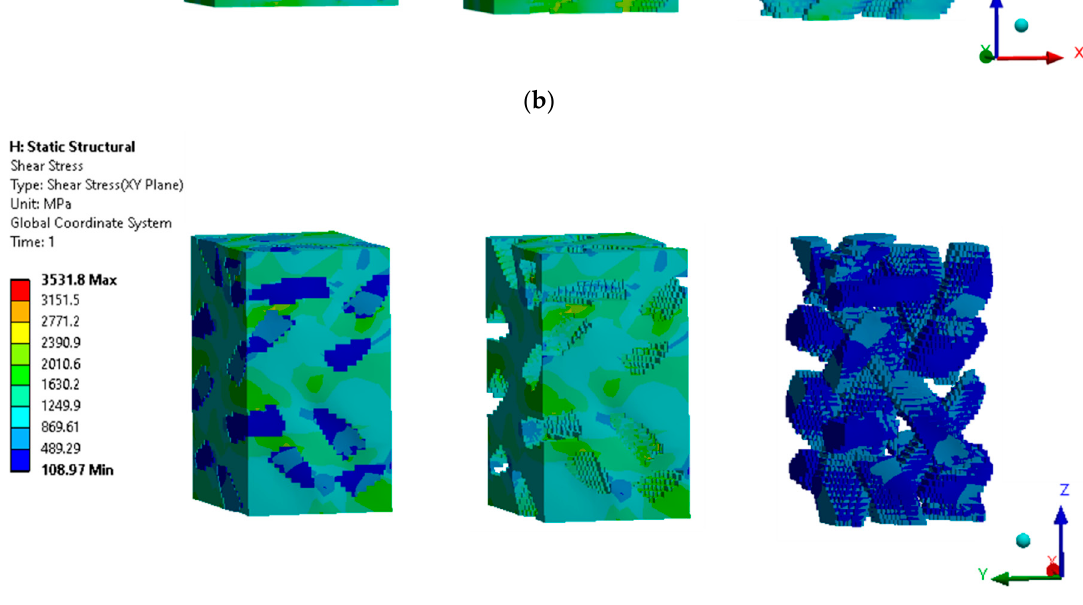
Figure 9. Stress in the finite element model ( a ) stress under pure z tension-composite model, matrix and yarns (fiber bundles); ( b ) stress under pure x tension-composite model, matrix and yarns (fiber bundles); and ( c ) stress under pure xy shear-composite model, matrix and yarns (fiber bundles).